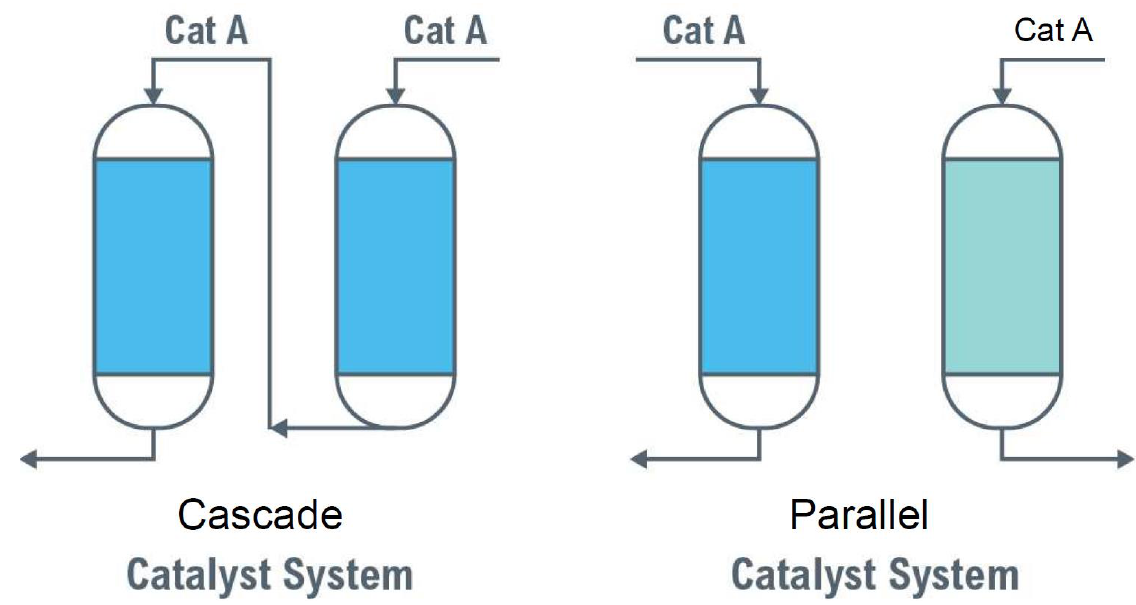
Figure 4. Cascade and parallel modes of fresh catalyst addition employed in this study.